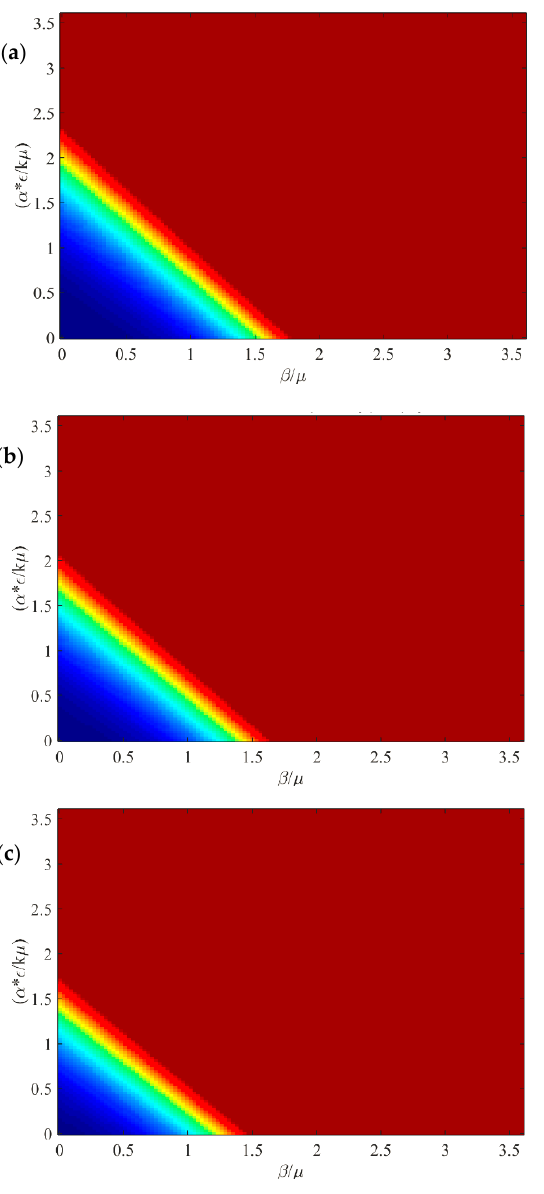
β (cid:15)α 𝜷 𝝐𝜶 µ , and R indirect = µ k with the with 𝝁 (cid:3415) , and 𝑹 𝒊𝒏𝒅𝒊𝒓𝒆𝒄𝒕 = 𝝁𝒌